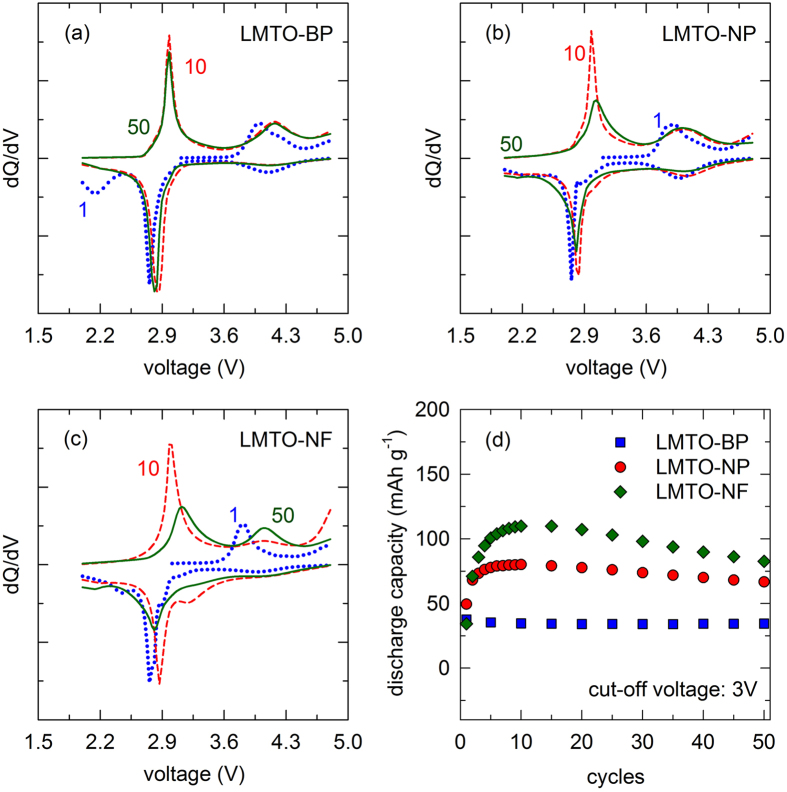
dQ/dV plot of (a) LMTO-BP, (b) LMTO-NP, and (c) LMTO-NF for the 1st, 10th, and 50th cycle. (d) Cycling stability curves of LMTO-BP, LMTO-NP, and LMTO-NF sample at C/5 and cut-off voltage 3 V.